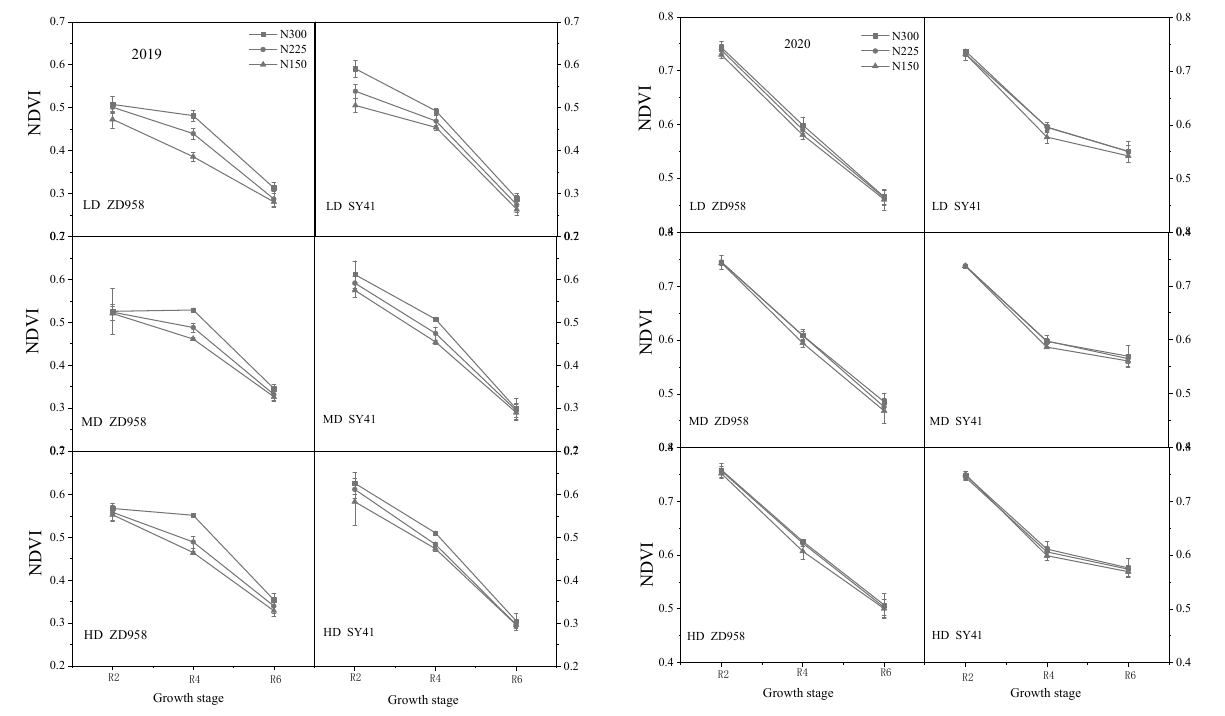
Figure 4. Effects of decreasing N rates under different planting densities on NDVI in 2019 and 2020.